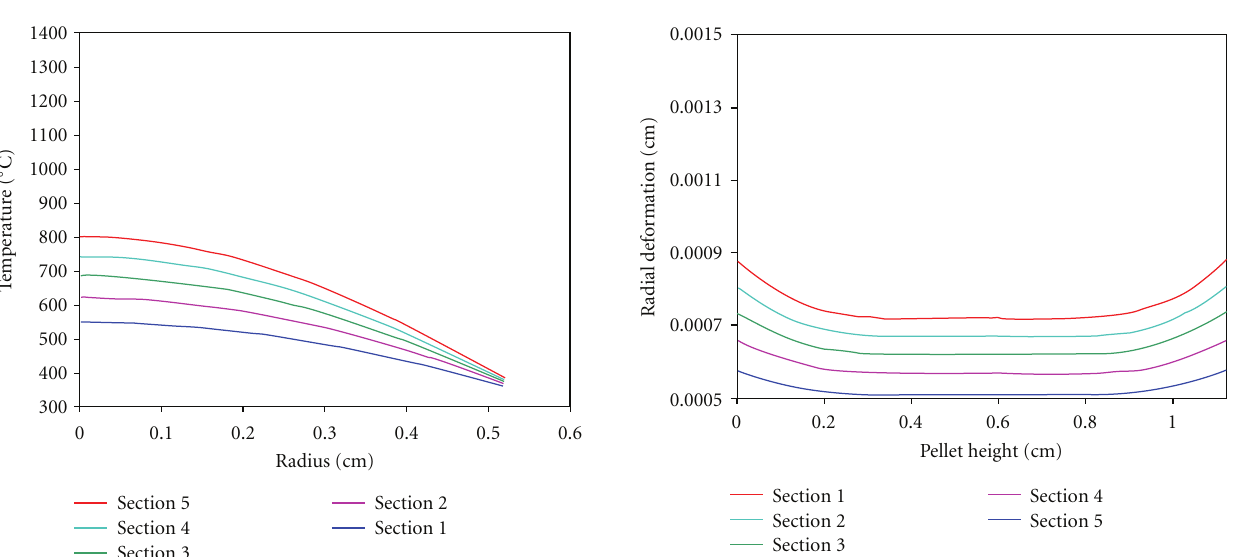
Figure 5: Temperature profile of the MOX fuel A.1.3 before ramping at EOL (Section 1 at the bottom of the fuel rod).